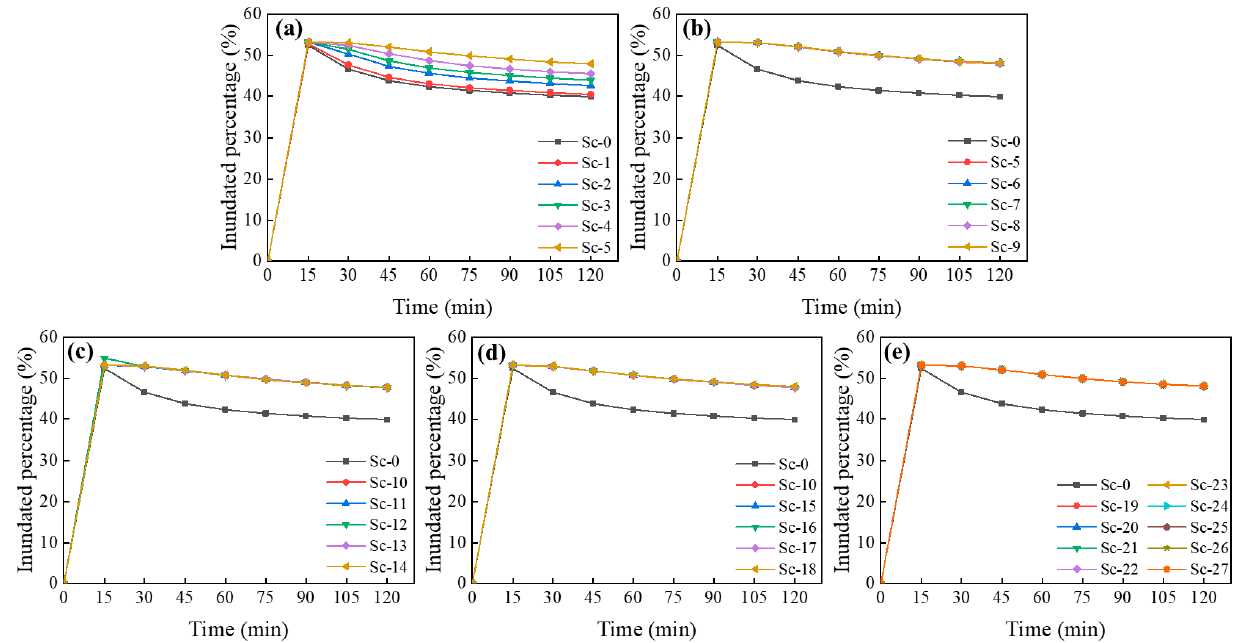
Figure 17. The time series plot of IA in 1 h event in considered scenarios of ( a ) connectedness of GR; ( b ) connectedness of RG; ( c ) edge density of GR; ( d ) edge density of RG; ( e ) flow distance of RG.